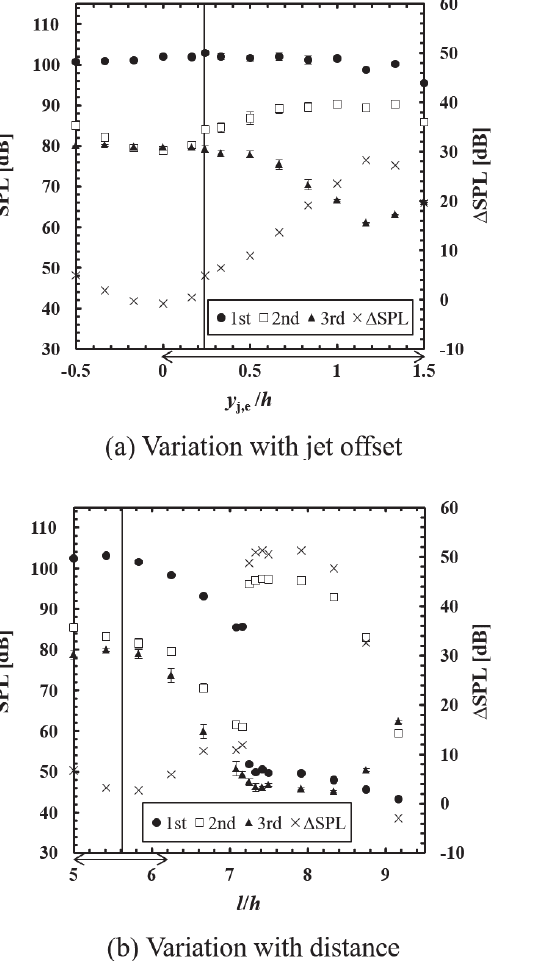
Figure 11. Variations of harmonic structure with blowing parameters. Lines and arrows show actual blowing conditions and practical ranges, respectively. All parameters other than the one being varied were fi xed to the actual blowing conditions shown in Table 1 ( h j = 39 (cid:3) , y j,e = 0.24, l / h = 5.6, Q = 16 L/min). Error bar is shown for each measured value. In (a), y j,e > 0 means that the reference jet direction is directed to outside the